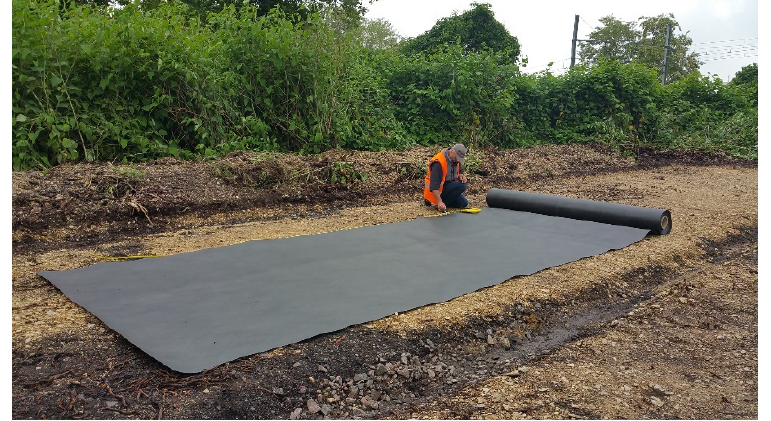
Figure 1. Installation of a synthetic geotextile as part of a tarping operation to control Asian knotweed. © INRAE.